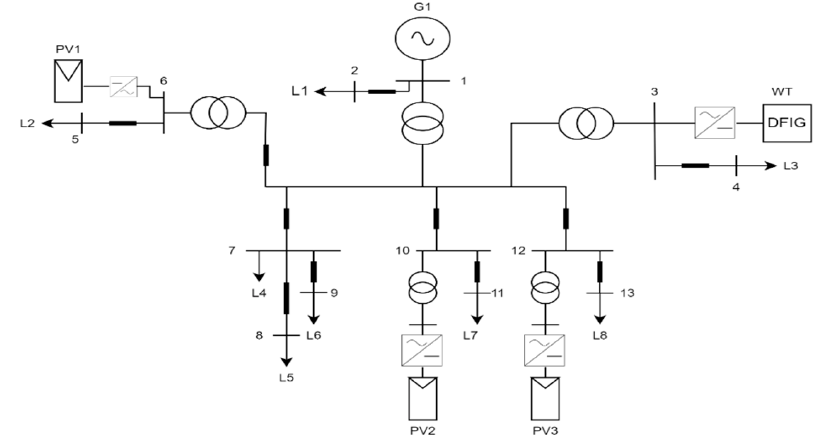
Figure 10. IEEE-13 bus test system.